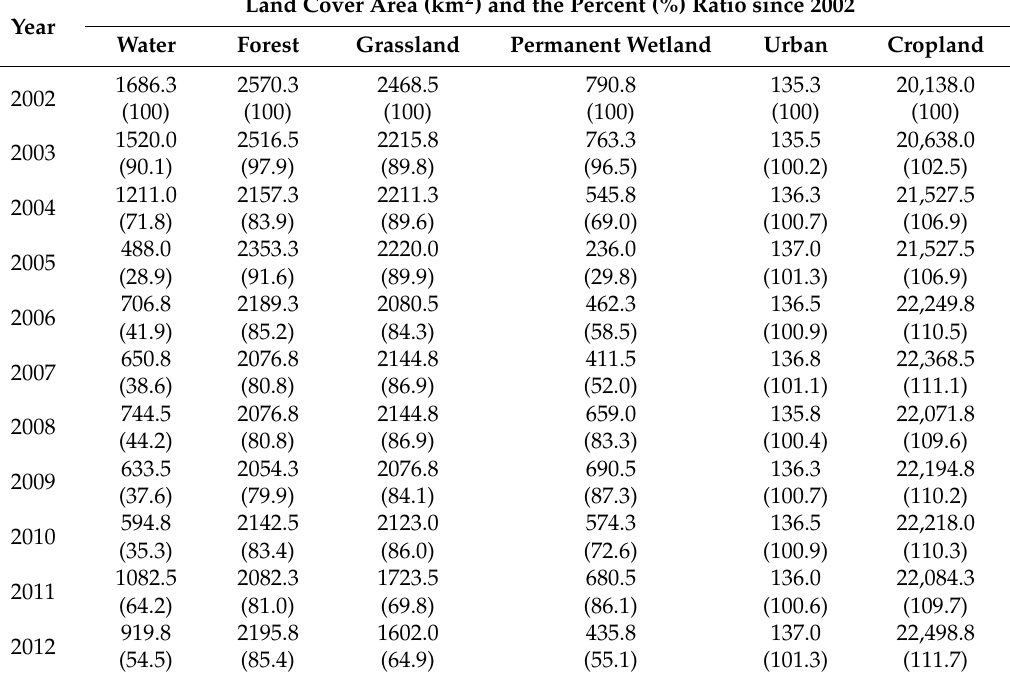
Table 2. Land cover change between 2002 and 2012 from MCD12Q1 product. Land Cover Area (km 2 ) and the Percent (%) Ratio since 2002 Year Water Forest Grassland Permanent Wetland Urban